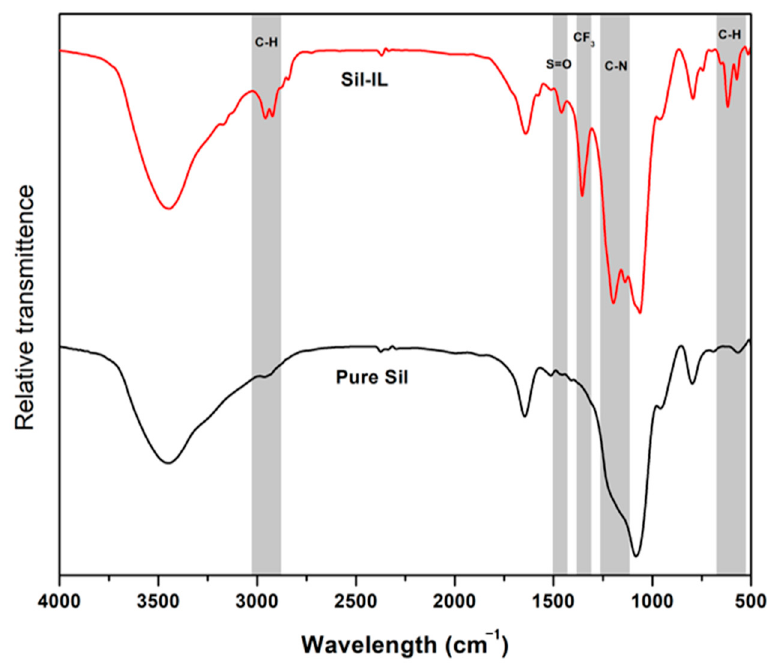
Figure 1. FTIR spectra for pure silica and Sil-IL particles.